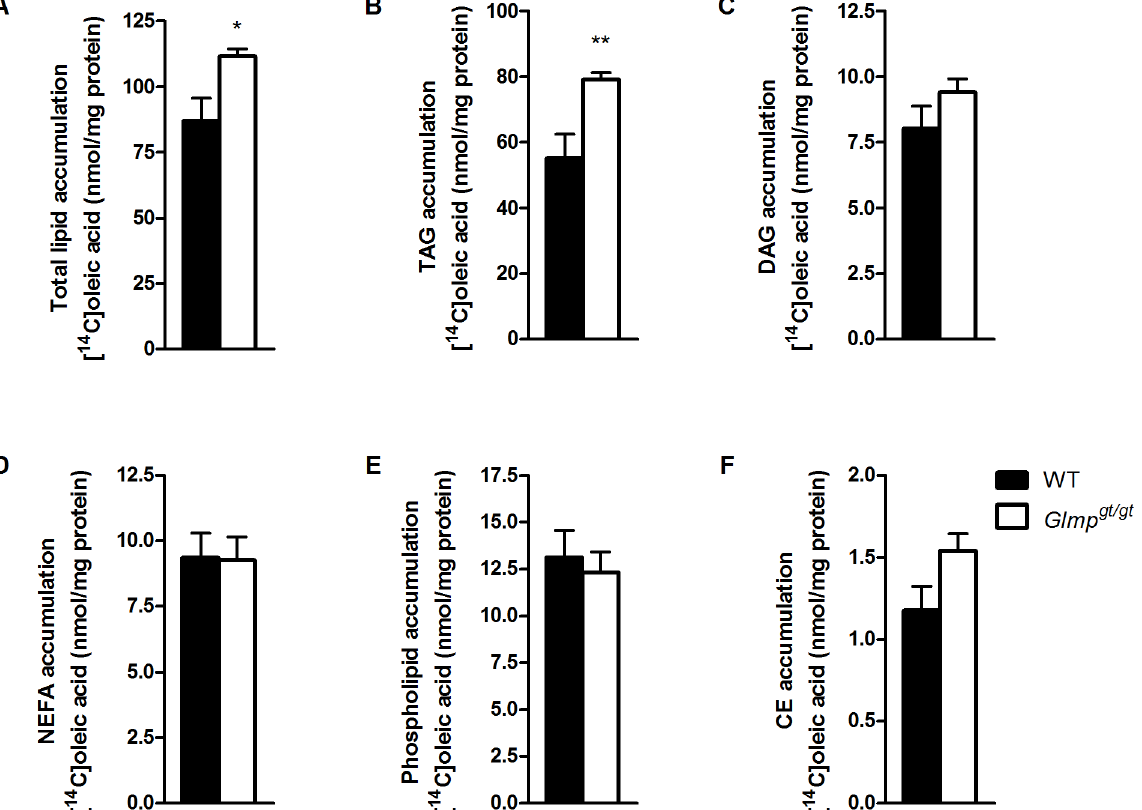
Fig 6. Glmp gt/gt hepatocytes incorporate more [ 14 C]oleic acid into triacylglycerol. Overnight cultured primary hepatocytes from WT and Glmp gt/gt mice were incubated with [ 14 C]oleic acid (0.5 μ Ci/mL, 100 μ M) for 4 h. (A) The total amount of cell accumulated lipids, (B) triacylglycerol (TAG), (C) diacylglycerol (DAG), (D) non-esterified fatty acids (NEFA), (E) phospholipids and (E) cholesterol esters (CE) were analyzed using thin layer chromatography (n = 9 experiments, representing 3 individual mice/genotype, with 3 replicates each, ** p < 0 . 01 vs. WT). Values are presented as mean ± SEM.